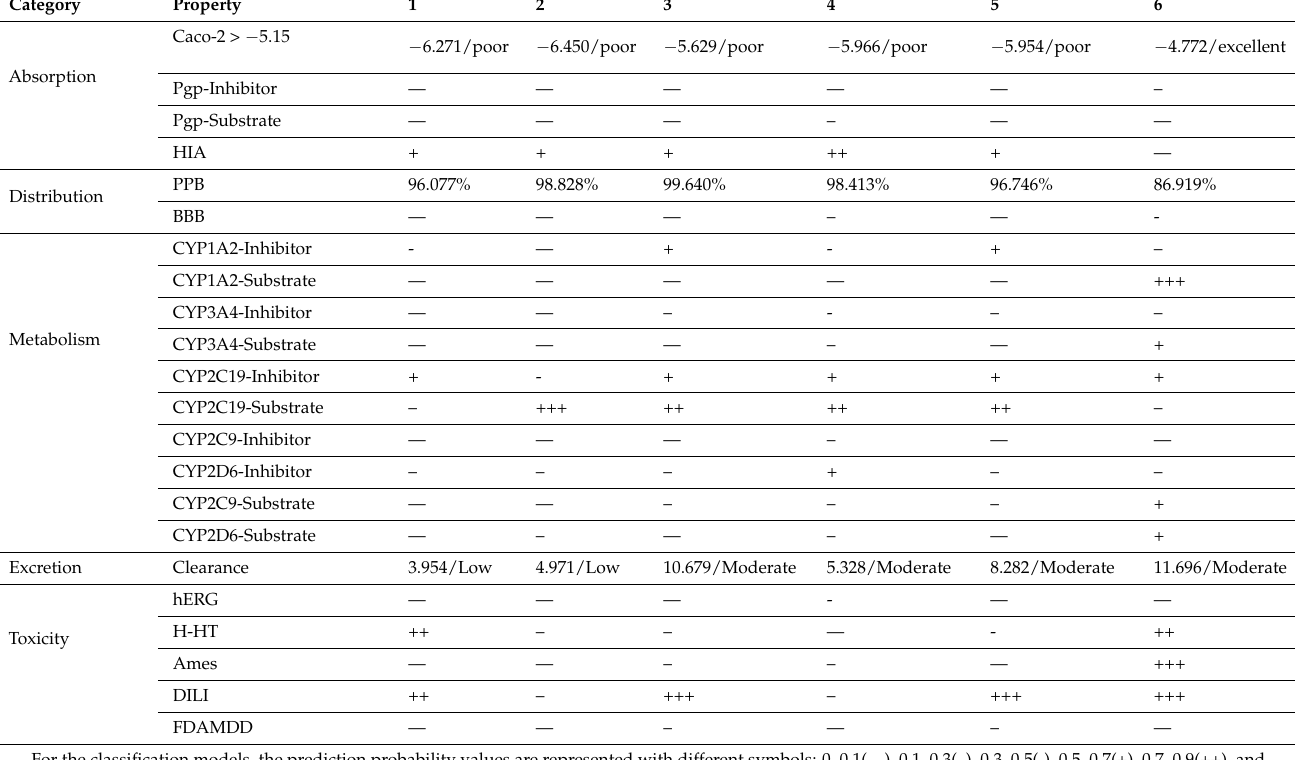
Table 5. The ADMET profile of hit